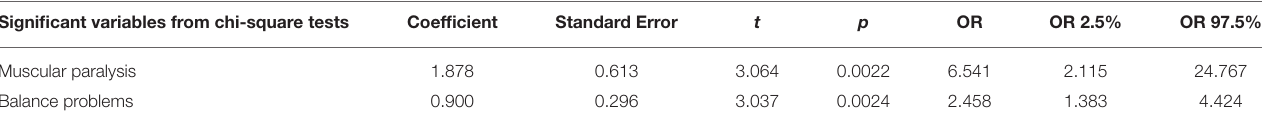
TABLE 1 | Results from the ordinal logistic regression for the significant variables identified from the chi-square tests with patients from the high, medium, or low depression severity categories. Significant variables from chi-square tests